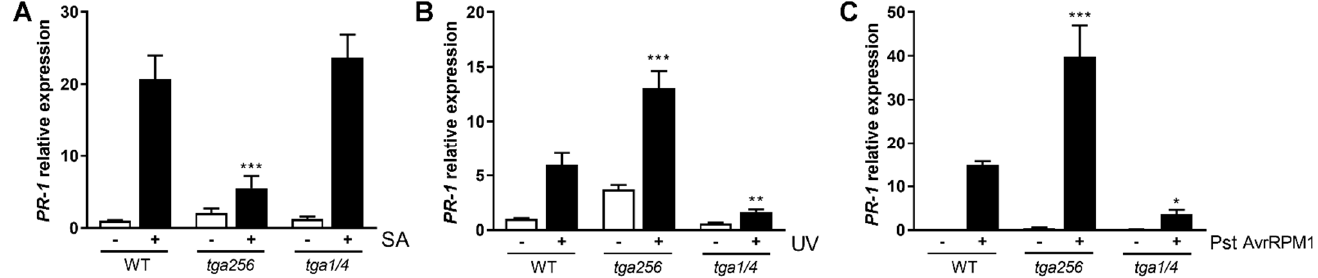
Figure 1. The TGA class II transcription factors negatively regulate PR-1 expression in conditions that induce SA accumulation. PR-1 transcript levels were evaluated in WT, tga256 triple mutants, and tga1 / 4 double mutants 24 h after ( A ) treatments with exogenous SA, ( B ) irradiation with UV-C, and ( C ) inoculation with avirulent P. syringae DC3000 (Pst) AvrRPM1. Fifteen-day-old plate-grown seedlings were used for SA and UV-C treatments, and 4-week-old soil-grown plants were used for the Pst inoculations. In ( A ), seedlings were transferred from plates to liquid ½MS media supple- mented with 0.5 mM SA (+) or without the hormone ( − ). In ( B ), seedlings were irradiated with UV- C for 20 min (+). Plants covered with a UV-C filter were used as controls ( − ). After the treatments, plants were transferred to normal growth conditions. In ( C ) plants were infiltrated with Pst DC3000/AvrRPM1 OD λ 600 = 0.01 (+) or 10 mM MgCl 2 ( − ) as control. Plants were frozen after 24 h of the different treatments. RNA was extracted, cDNA was synthesized, and PR-1 expression was eval- uated by qPCR. Bars indicate the mean of the relative expression of PR-1 ± SEM of three biological replicates. Asterisks indicate statistical differences according to a 2-way ANOVA and Dunnett’s post-test comparing the mutant genotypes with the WT plants (*: p < 0.05, **: p < 0.01, ***: p < 0.001). No statistically significant differences were found in control conditions ( − ) between WT and tga256 mutant plants ( p = 0.9037 in ( A ), p = 0.0640 in ( B ), and p = 0.9951 in ( C )).